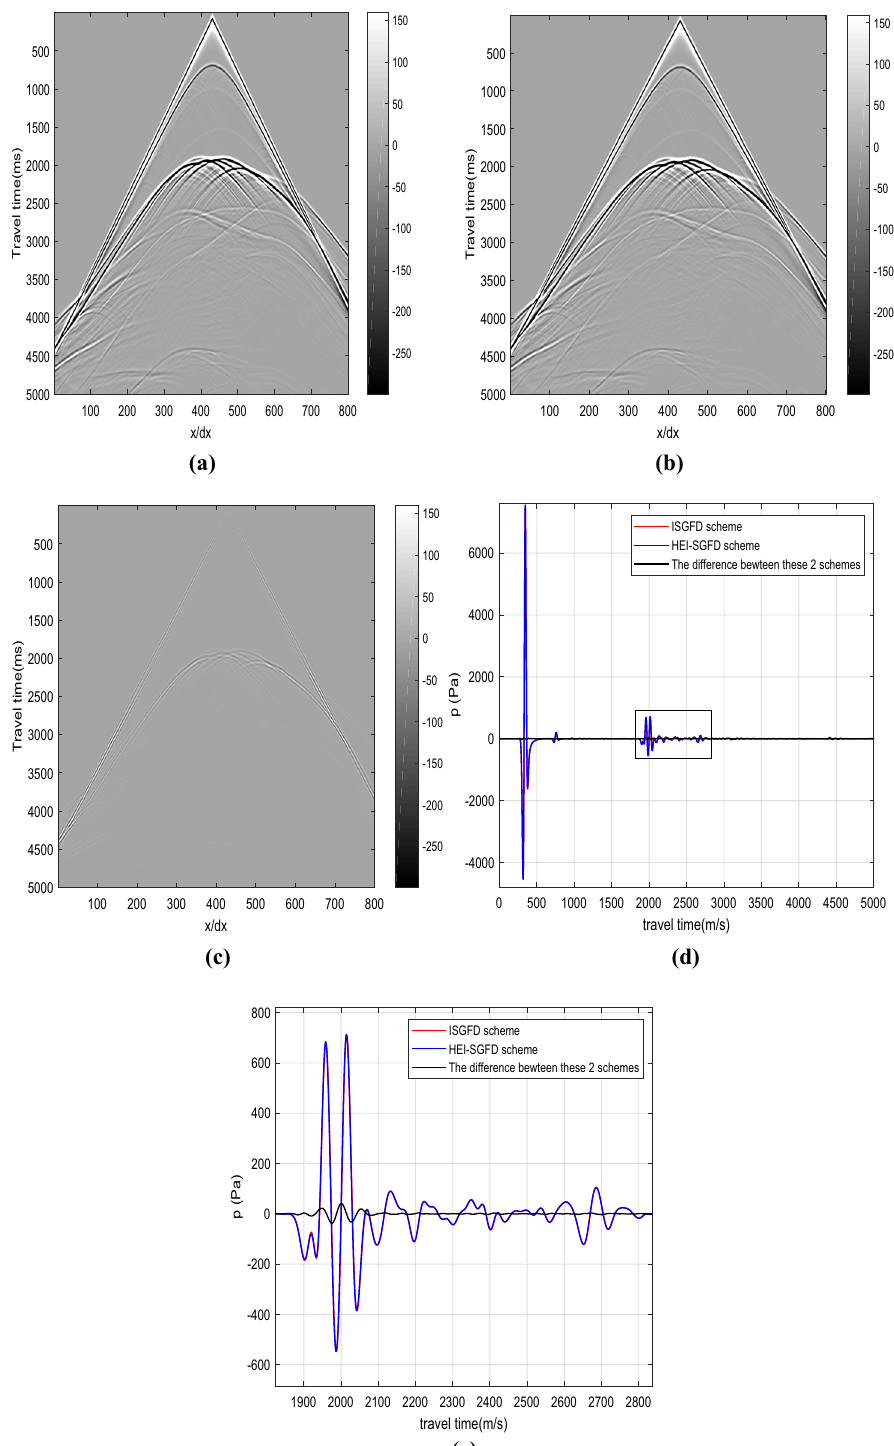
Figure 5. Seismic records p obtained with different SGFD schemes. ( a ) The implicit SGFD scheme; ( b ) the HEI-SGFD scheme; ( c ) the difference between ( a ) and ( b ); ( d ) the seismograms from ( a ) to ( b ) at x/dx = 405; ( e ) local enlargement of ( d